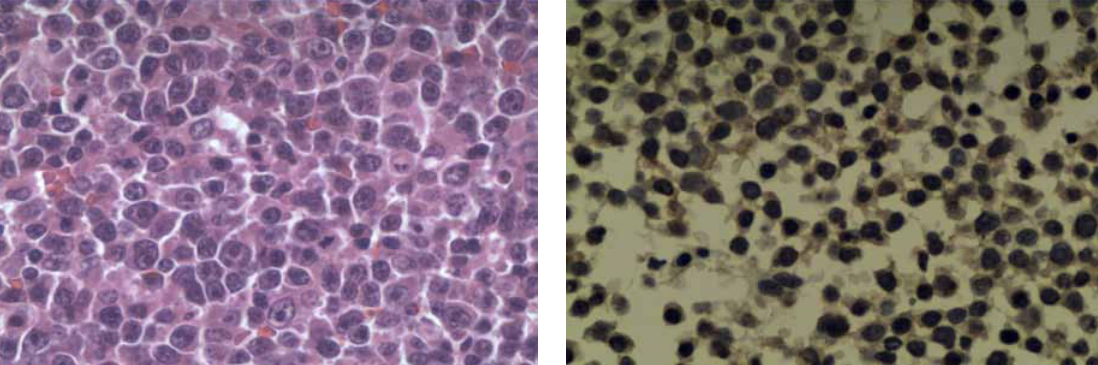
Figure 2b. CD20(+)(Hematoxylin&Eosin stain,400 X)